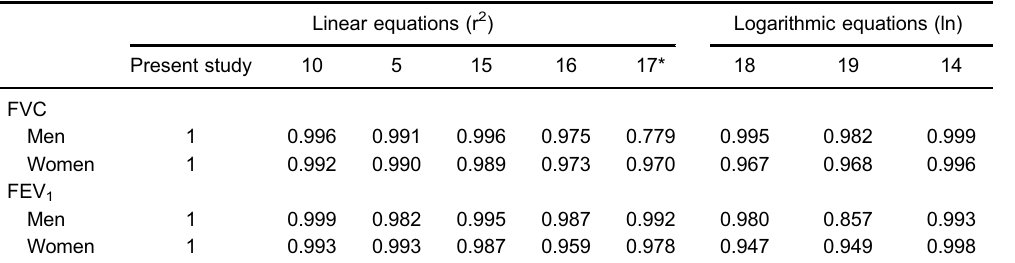
Table 5. Correlations of FVC and FEV 1 with different equations.